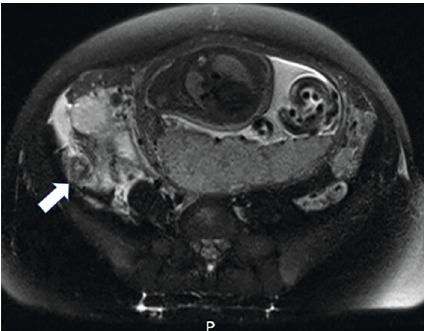
Figure 1: Acute appendicitis detected on T2-weighted MRI image. Dilated appendix (arrow) in the right lower quadrant with surrounding in fl ammatory changes.